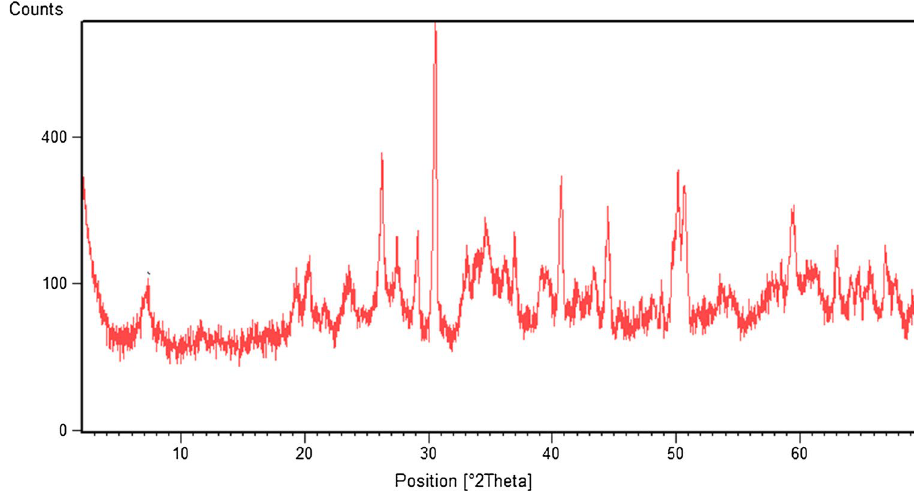
Fig. 2 X-ray diffraction of